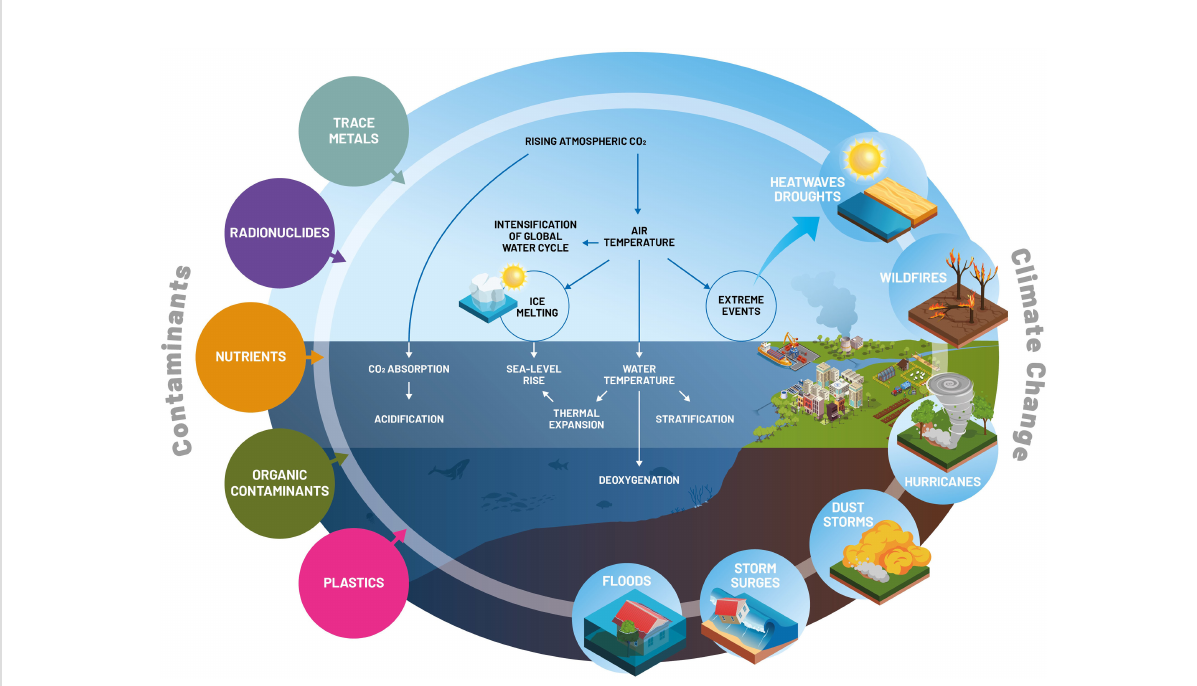
FIGURE 1 Conceptual model of the main climate change drivers and contaminants interacting and potentially exacerbating negative impacts on coastal and ocean